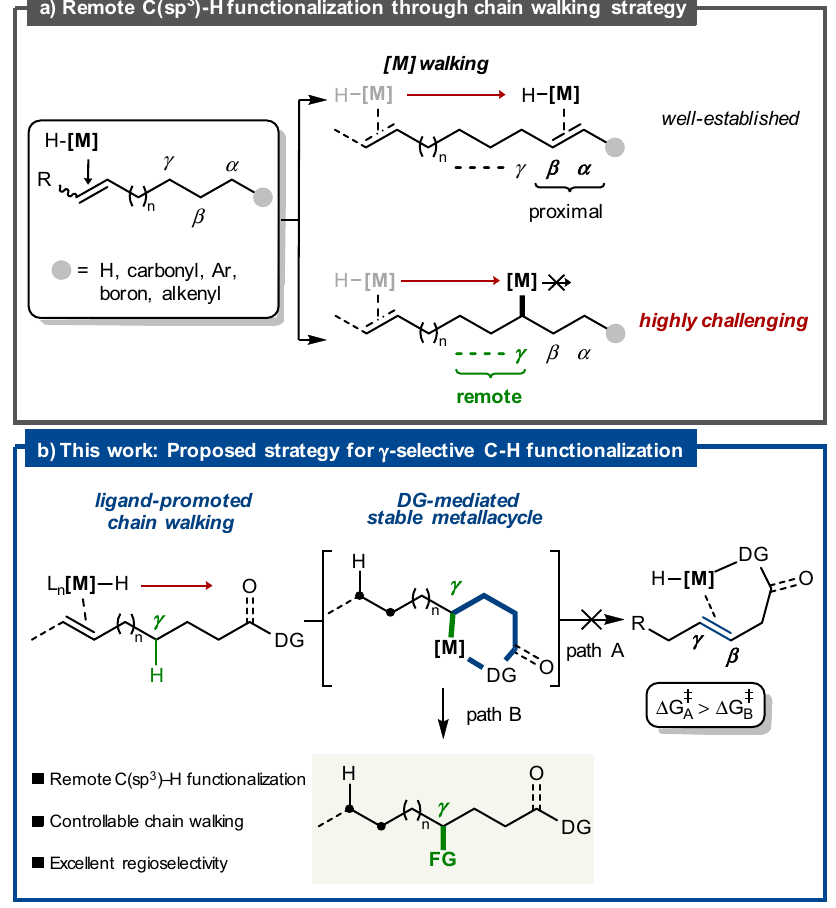
Fig. 1 Regioselective migratory hydrofunctionalization of unactivated alkenes. a Remote C( sp 3 ) – H functionalization through chain walking strategy. b Proposed strategy for γ -selective C( sp 3 ) – H